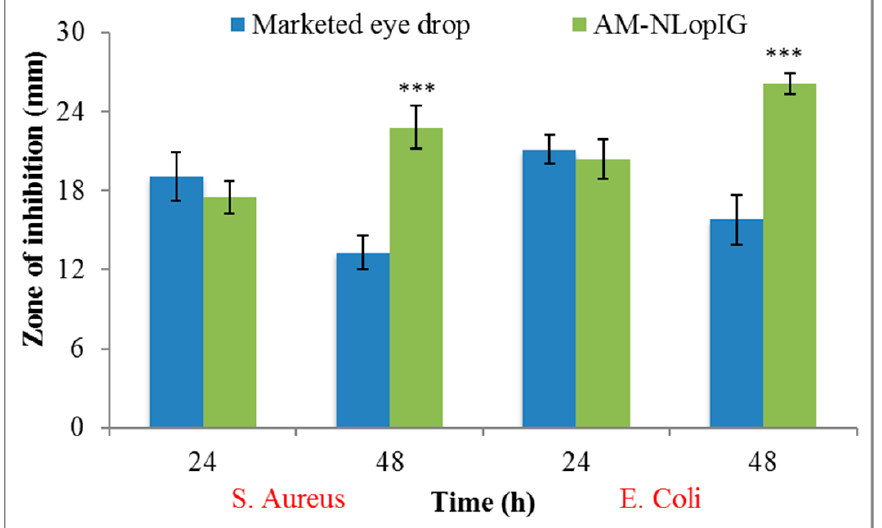
Figure 10. Antimicrobial graph of AM-NLopIG and eye drop evaluated against S. aureus and E. coli . Results shown as mean ± SD. *** indicates significant difference to the marketed eye drop.